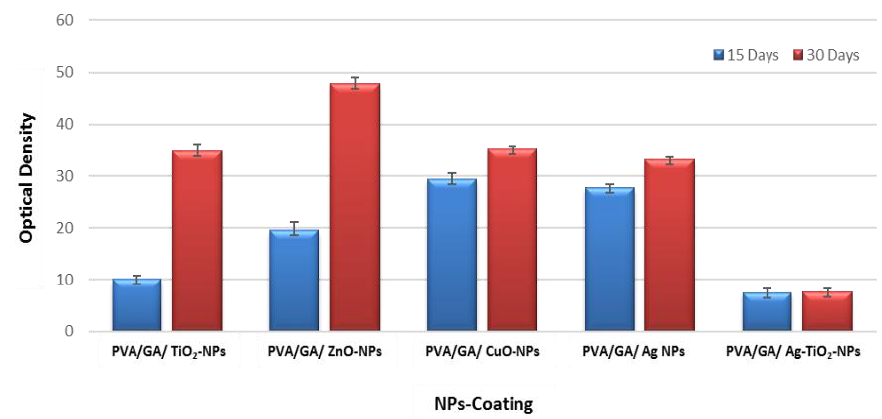
Figure 7. Optical density analysis of the metallic nanoparticle coatings at immersion times of 15 days (blue) and 30 days (red). The error bars indicate the standard deviation of 3 measurements.